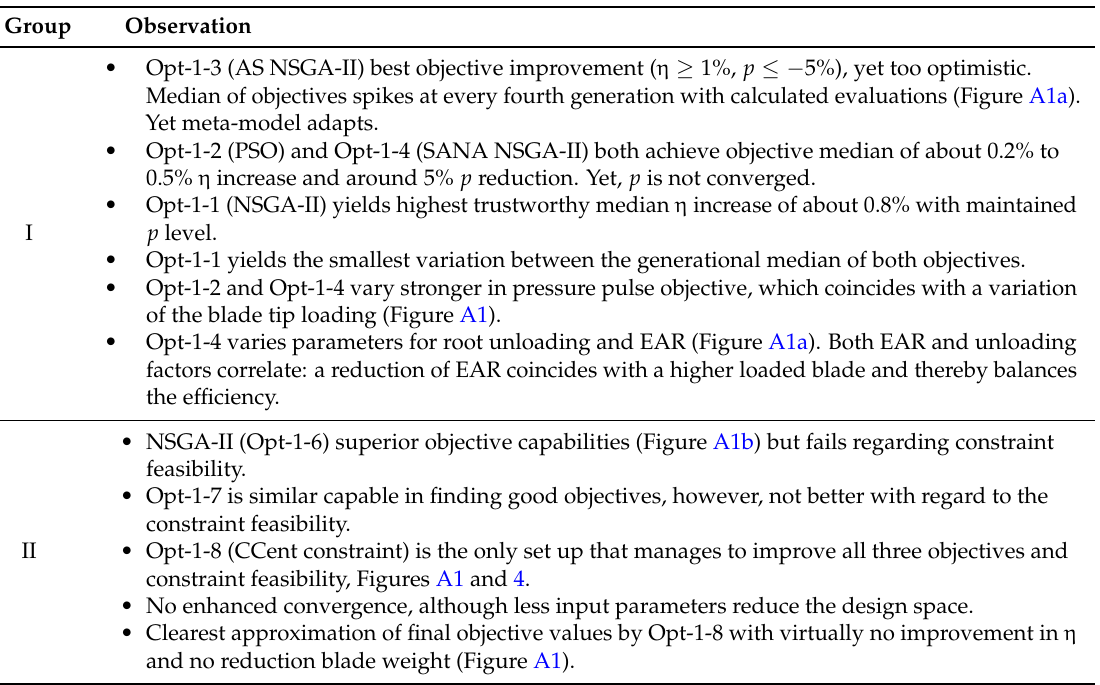
Table 5. Potential improvement and convergence observations of